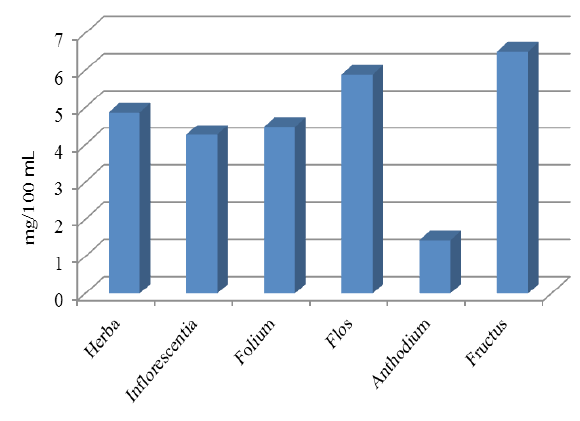
Figure 1: The contents of flavonoids in herbal infusions.